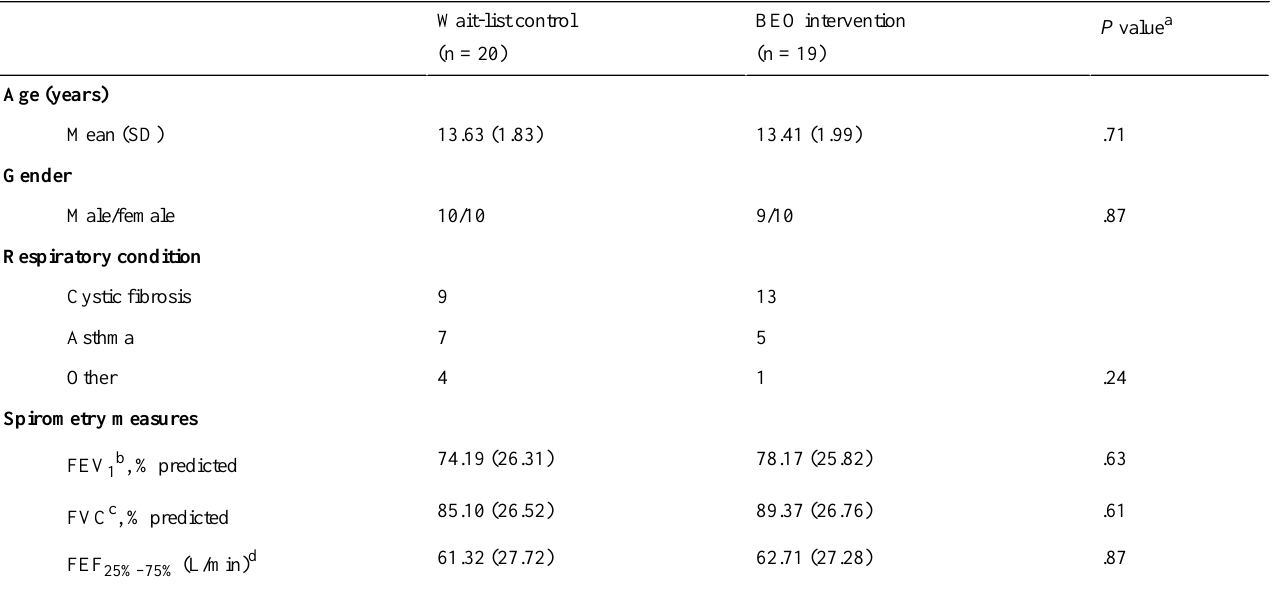
Table 1. Sample characteristics at baseline for both wait-list control and Breathe Easier Online (BEO) intervention conditions